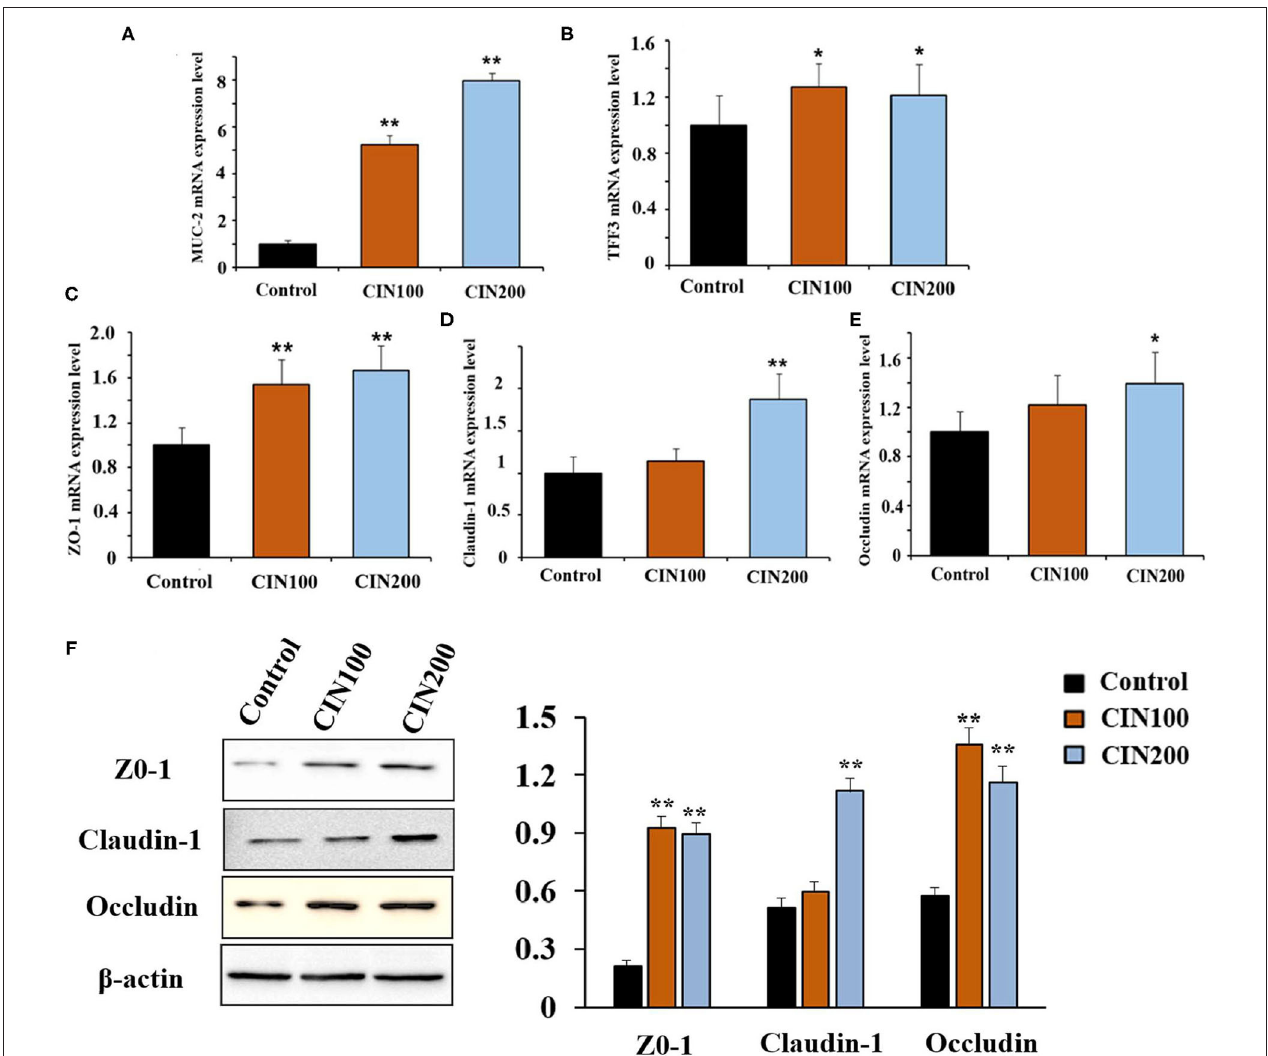
FIGURE 2 | Cinnamaldehyde supplementation promotes the mRNA levels of MUC2, TFF3, TJs, and protein levels of TJs (ZO-1, Claudin-1, and Occludin) in early weaned rats. (A) MUC2. (B) TFF3. (C) ZO-1. (D) Claudin-1. (E) Occludin. (F) Protein levels of TJs. mRNA levels were normalized by GAPDH and protein levels were normalized β -actin. Data are expressed as mean ± SD. * P < 0.05, ** P < 0.01. One-way ANOVA was carried out for each comparison with HSD